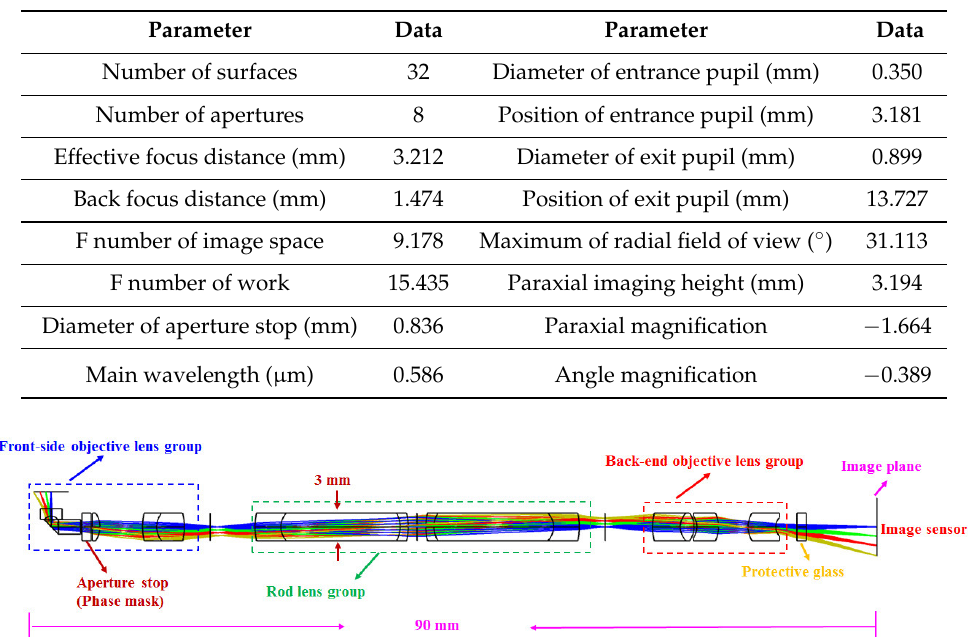
Table 1. Detailed information of the optical endoscope.